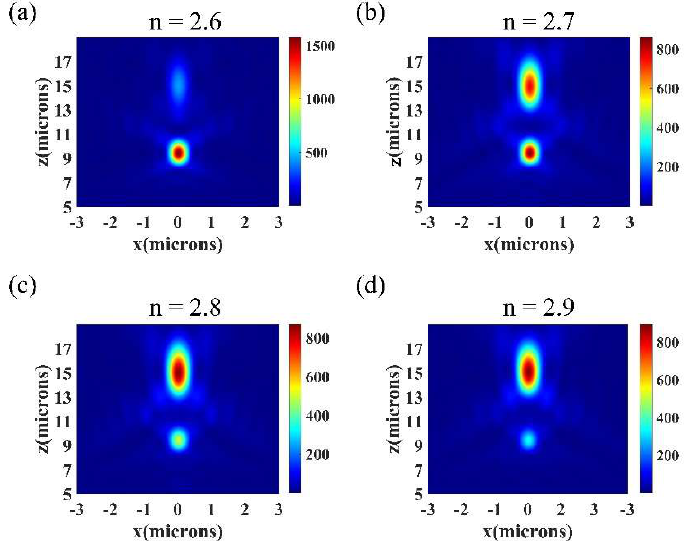
Figure 6. The intensity distribution of the bifocal metalens on the x–z plane when the refractive index of BTO was 2.6, 2.7, 2.8 and 2.9.